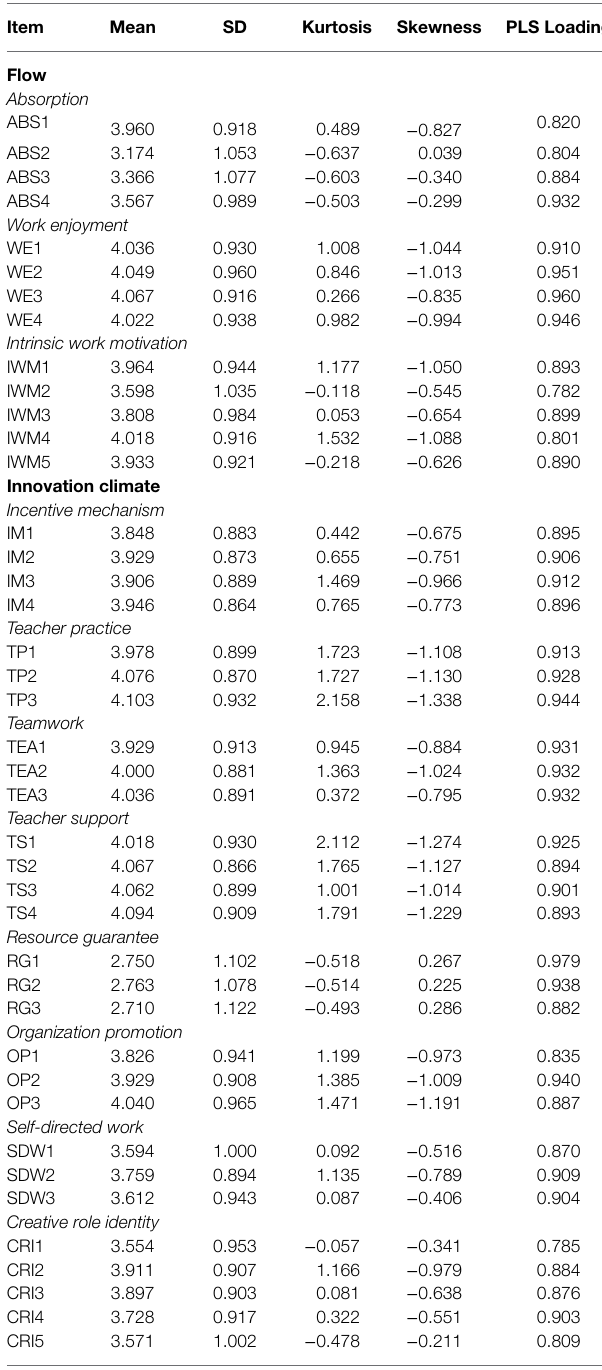
TABLE 2 | Means, standard deviations, and PLS loadings. TABLE 1 | Characteristics of the respondents ( N =